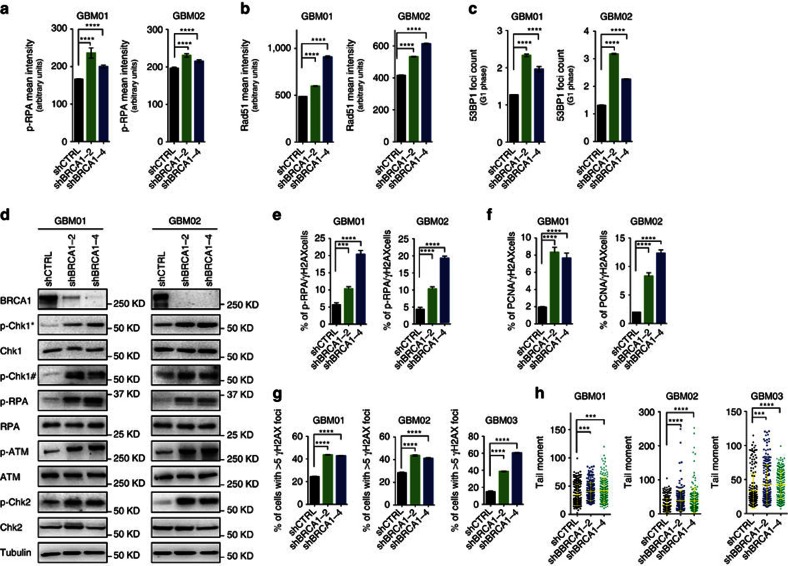
BRCA1 protects GBM cells from replication stress-induced DSBs formation.(a) Microscopy analysis and quantification of pRPA mean signal intensity (in S phase) in GBM cells transduced with shCTRL or two independent BRCA1-targeting shRNAs (shBRCA1-2 and shBRCA1-4). (b) Microscopy analysis and quantification of Rad51 mean signal intensity (S phase) in GBM cells transduced with shCTRL or two independent BRCA1-targeting shRNAs (shBRCA1-2 and shBRCA1-4). (c) Microscopy analysis and quantification of 53BP1 foci count (G1 phase) in GBM cells transduced with shCTRL or two independent BRCA1-targeting shRNAs (shBRCA1-2 and shBRCA1-4). (d) Immunoblot analysis of DDR activation in GBM cells transduced with shCTRL or two independent BRCA1-targeting shRNAs (shBRCA1-2 and shBRCA1-4). * Chk1Ser317; # Chk1Ser345. (e) FACS quantification of double-positive p-RPA/γH2AX GBM cells transduced with shCTRL or two independent BRCA1-targeting shRNAs (shBRCA1-2 and shBRCA1-4). (f) FACS quantification of double-positive PCNA/γH2AX GBM cells transduced with shCTRL or two independent BRCA1-targeting shRNAs (shBRCA1-2 and shBRCA1-4). (g) Microscopy analysis and quantification of γH2AXfoci count in GBM cells transduced with shCTRL or two independent BRCA1-targeting shRNAs (shBRCA1-2 and shBRCA1-4). (h) Comet assay and tail moment quantification of DSBs in GBM cells transduced with shCTRL or two independent BRCA1-targeting shRNAs (shBRCA1-2 and shBRCA1-4). Statistical significance was calculated by one-way ANOVA and Tukey’s multiple comparisons test in a–c,e–h and all data are shown as means ±s.d. and performed as technical triplicates. (*P<0.05, **P<0.005, ***P<0.005, ****P<0.0001; NS represents non-significance).